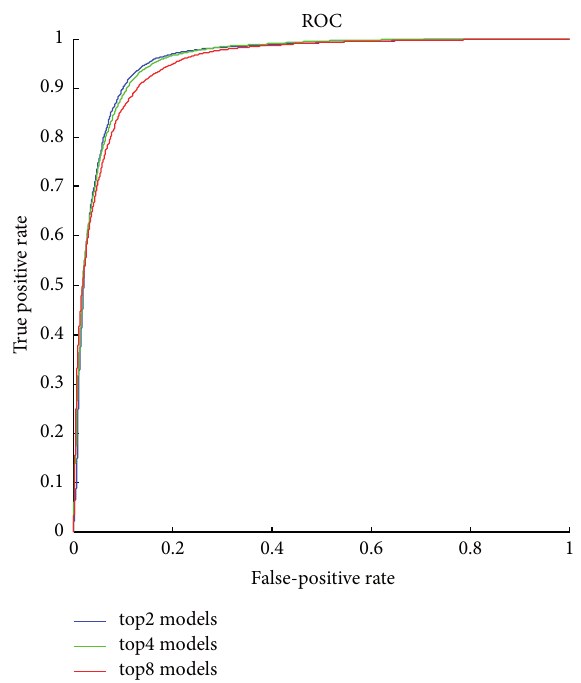
Figure 7: ROC curves for EDGE5 × 5 features.